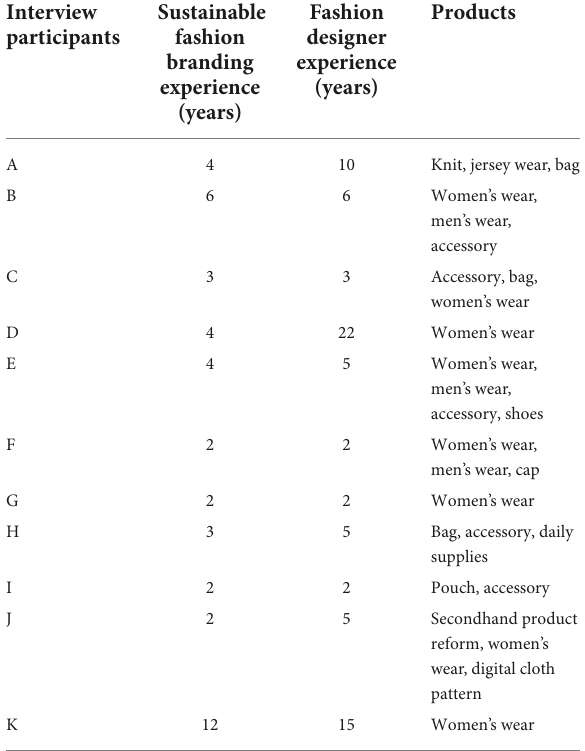
TABLE 1 Articles on sustainable fashion brands (SFBs) selected from the world’s top popular fashion magazines.